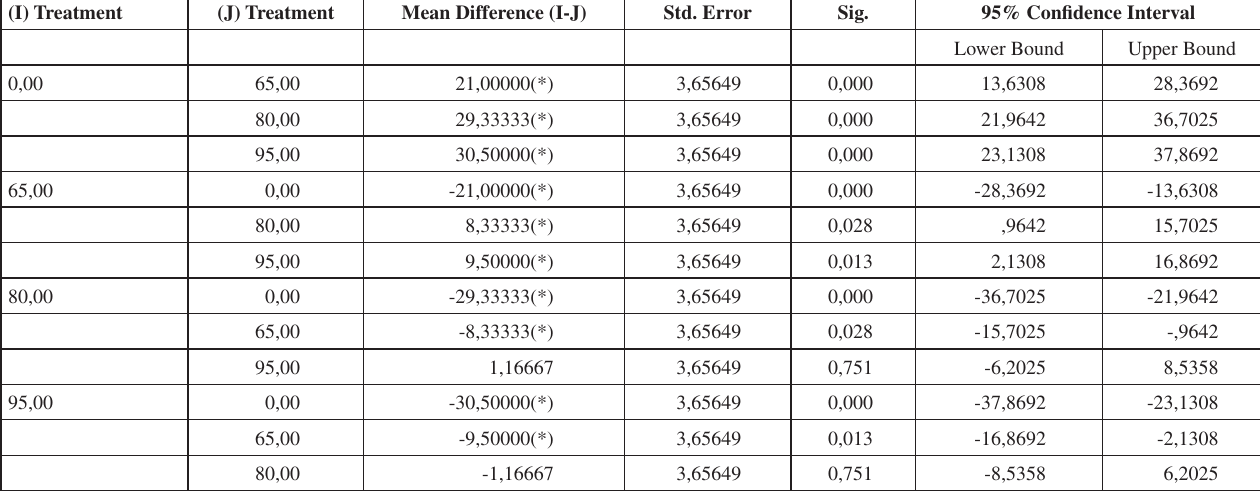
Table 3 .: Analysis of variance tables Multiple Comparisons ( Dependent Variable: